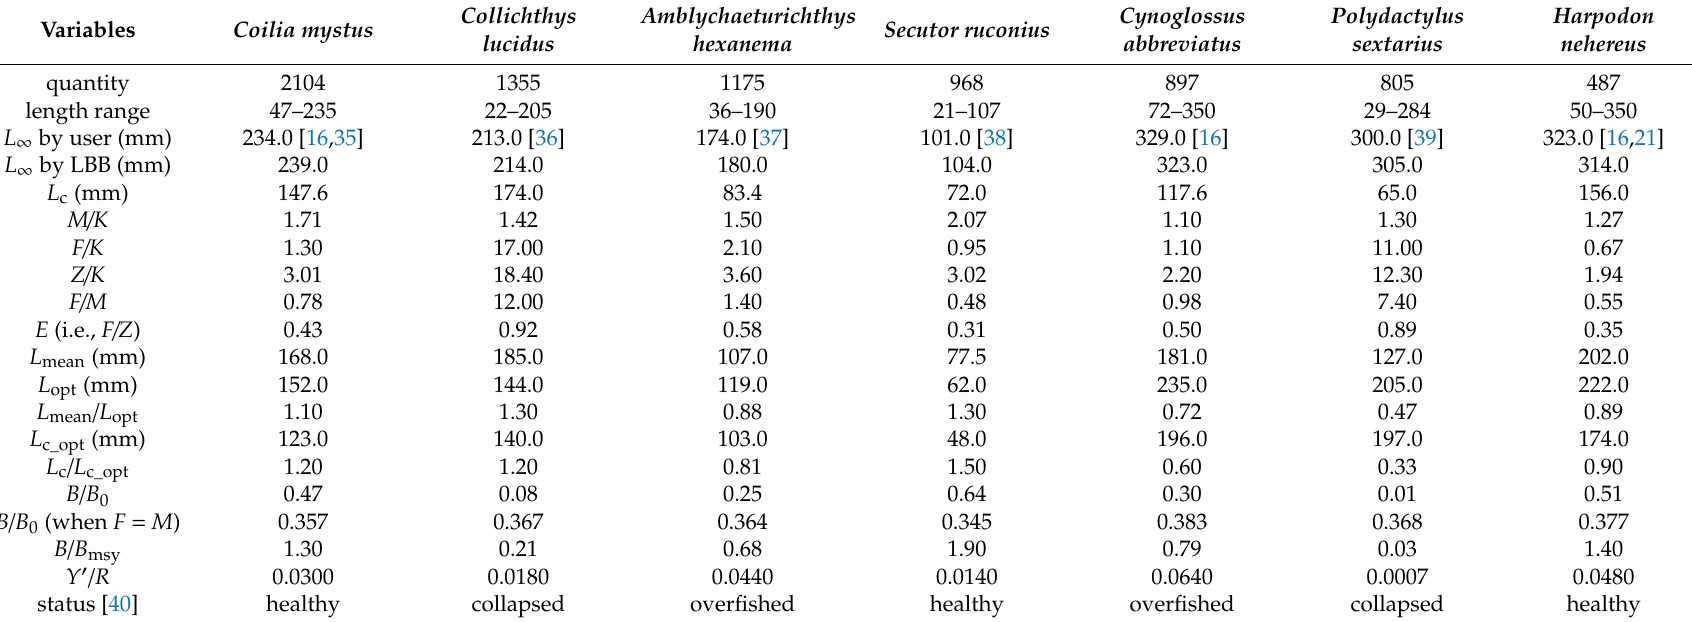
Table 2. Descriptive variables concerning the exploitation of seven dominant fish species in the Min River Estuary in